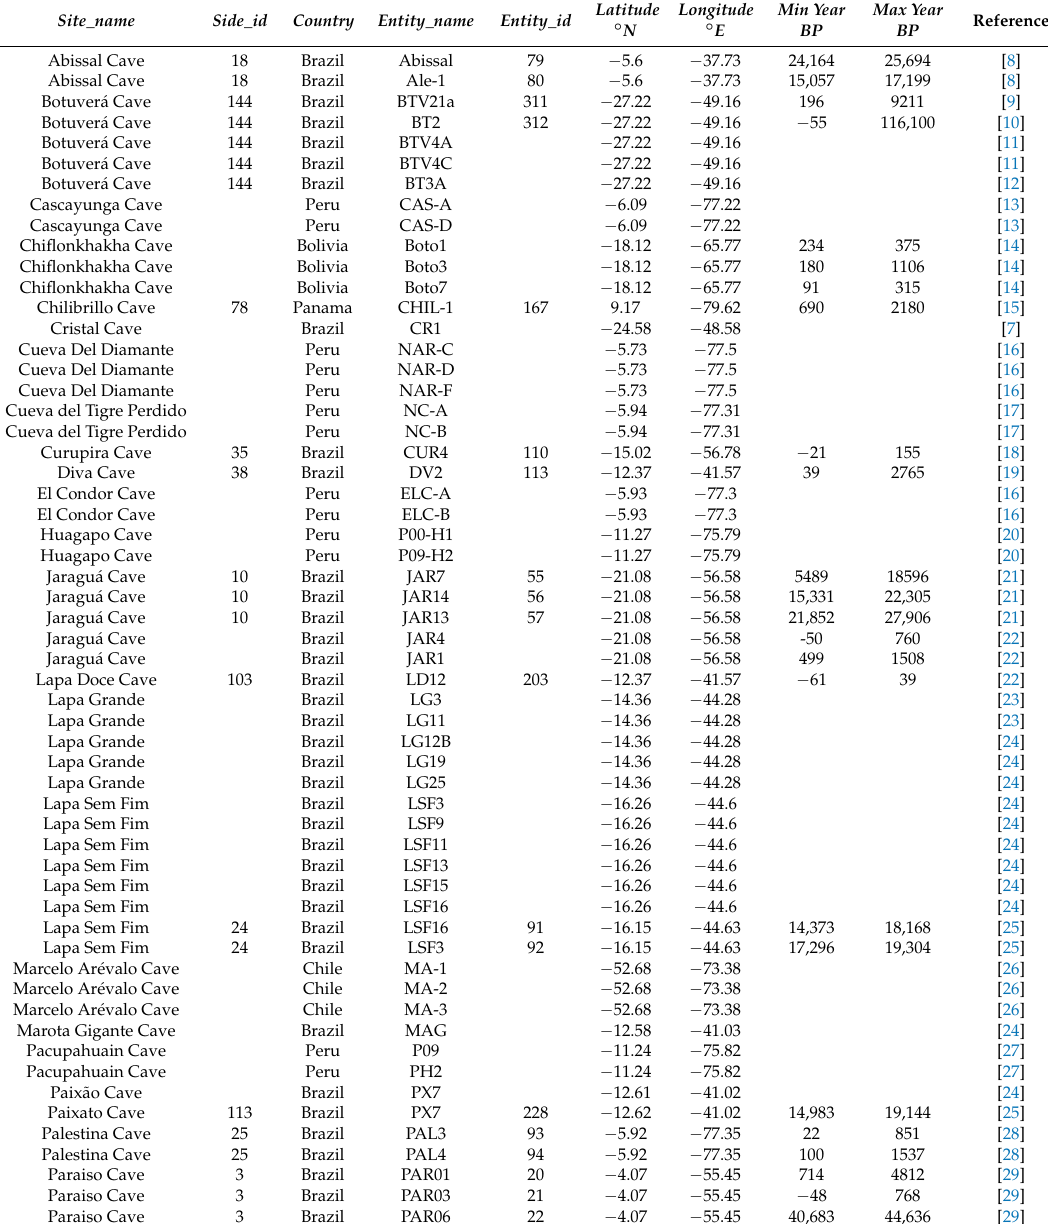
Table 1. Cave sites (name and id. in SISAL) and entities (name and id. in SISAL) (i.e., speleothems) in South America. Cave sites and entities in SISAL_v1 have a unique identifier (id.). This field is empty for caves and entities not in the current version of the database. Minimum (min) and maximum (max) year are the youngest and oldest age of the isotope time series in the SISAL_v1 database. Headers in italic (e.g., Site name) are searchable variables in SISAL_v1